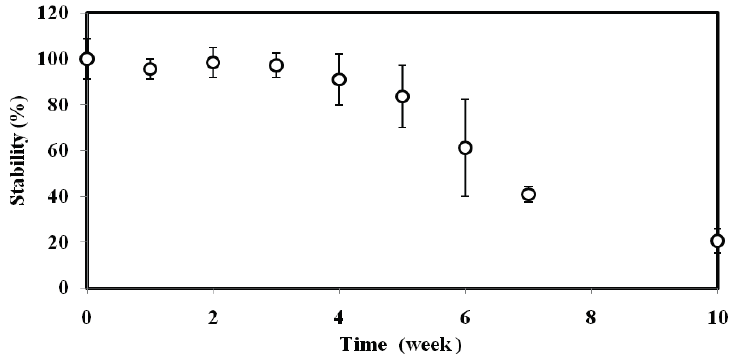
Figure 4. The stability profile of GFP E. coli biosensor at 0.8 Abs OD (600 nm) cell concentration, 4% alginate and 0.15 M CaCl 2